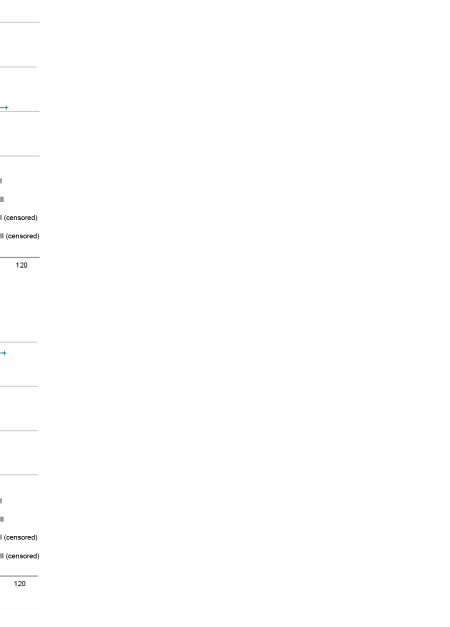
Figure 3. Kaplan–Meier survival curves demonstrating the OS ( A ) and NCR ( B ) between the study